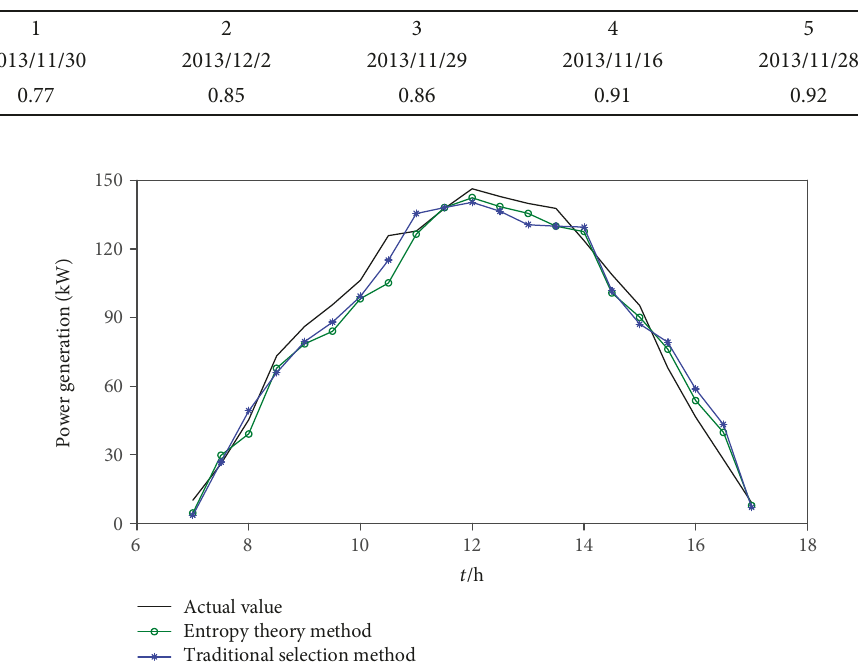
Table 2: Selection results of similar days.